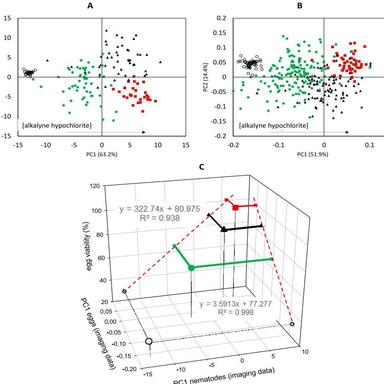
Characterisation of treatments from the imaging data. A: PCA variance space from the multispectral imaging data of nematodes. B: PCA variance space from the multispectral imaging data of eggs. C: relation between the imaging data from both sample types and egg viability.- - Control; L; M; H; regression imaging data vs. egg viability.